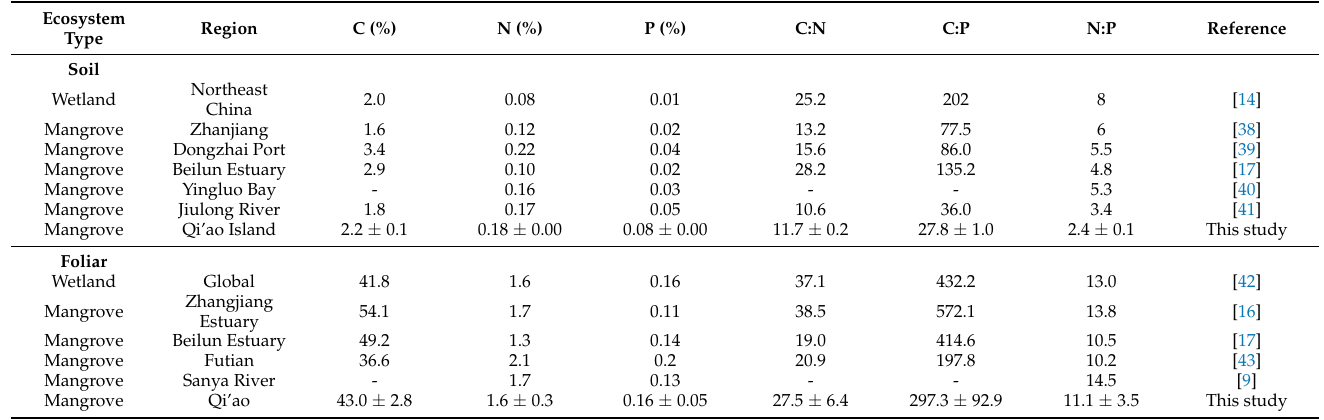
Table 1. Comparison of soil and foliar C, N and P concentrations and ratios between this study and previous